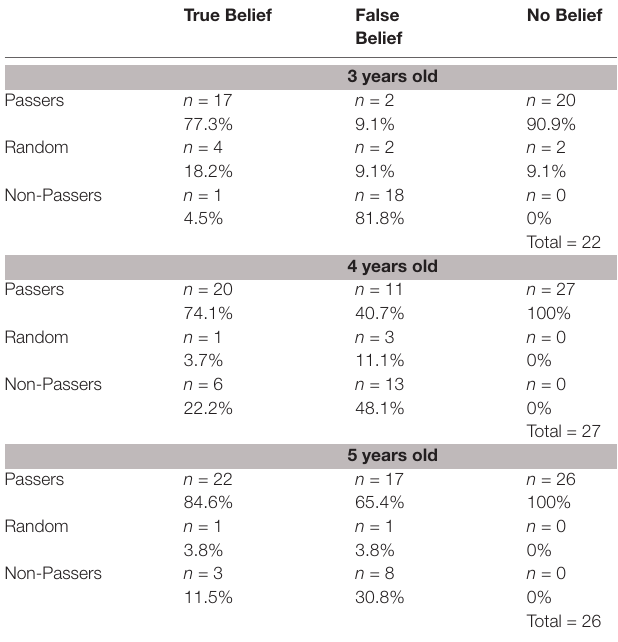
TABLE 1 | The proportion of Passers, Non-Passers and Random in each theory of mind (ToM) task condition, broken down by